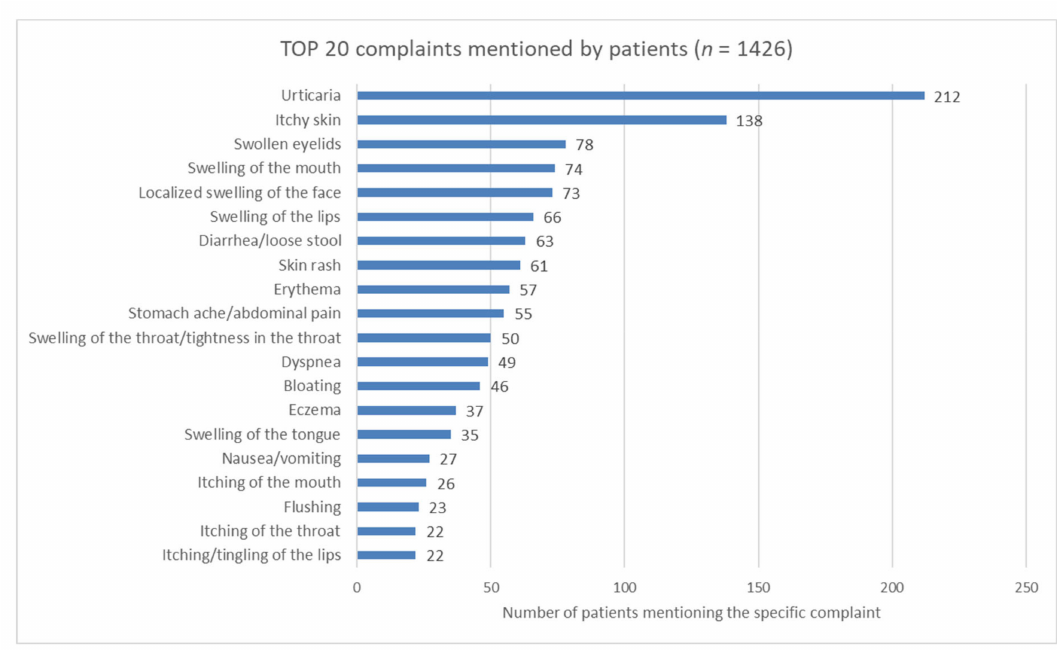
Figure 2. The 20 most commonly mentioned complaints in the patient group.